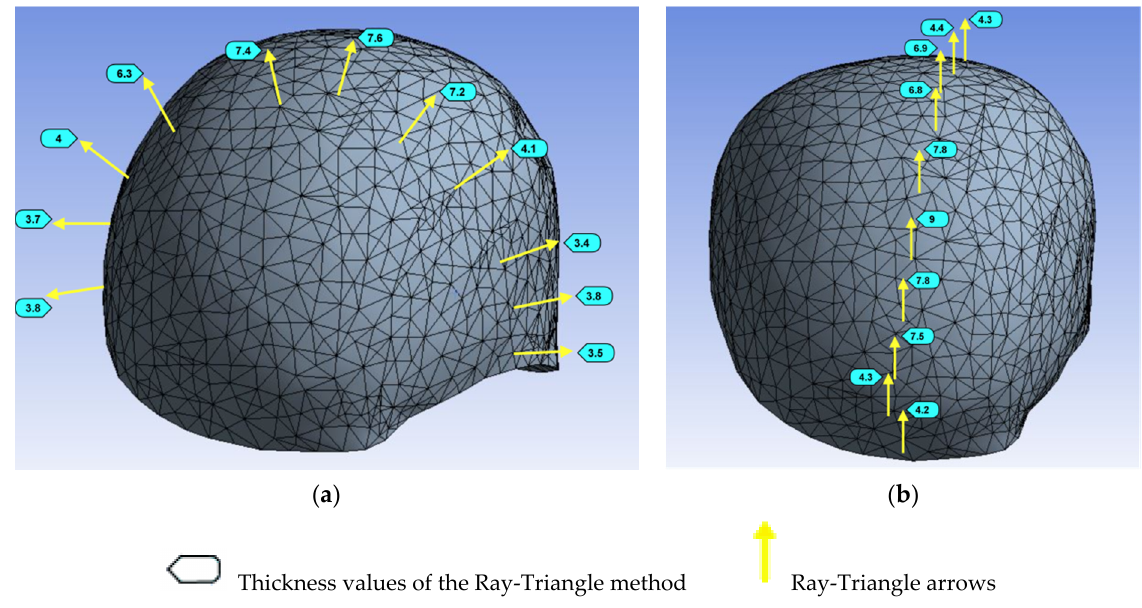
Figure 16. Skull thickness measurement results of the Ray-Triangle method: ( a ) values obtained from left temporal bone to right temporal bone; ( b ) values obtained from frontal bone to parietal bone.